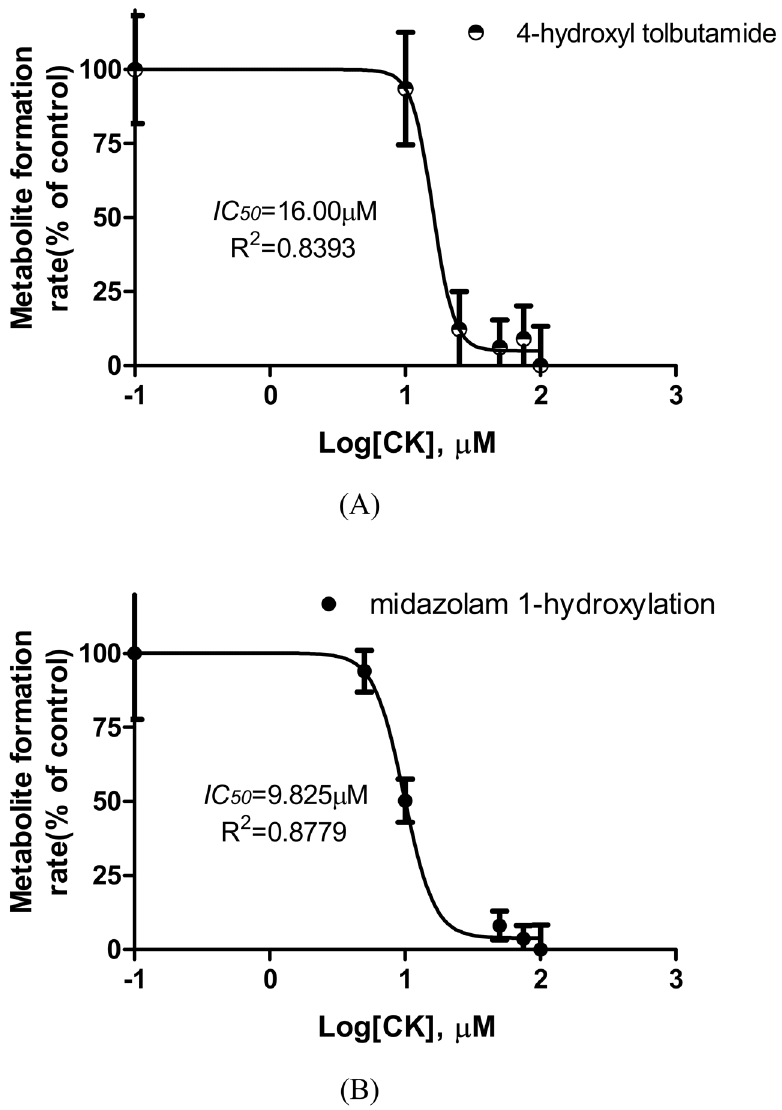
Fig 5. Effect of CK on the metabolic reactions of the CYP2C9 (A) and CYP3A4 (B) specific substrates in HLMs. Note: The incubation conditions are described in the materials and methods section. Each data point represents the average of triple determinations and error